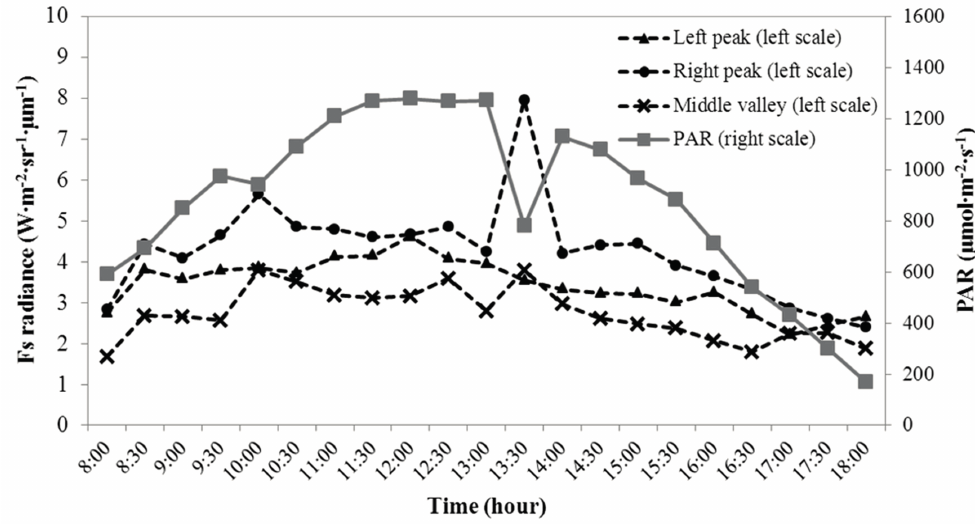
Figure 7. Diurnal variations (left scale) of the solar-induced chlorophyll fluorescence (Fs) at 684 nm, 761 nm, and 699 nm. Photosynthetically Active Radiation (PAR, right scale) was also shown in the